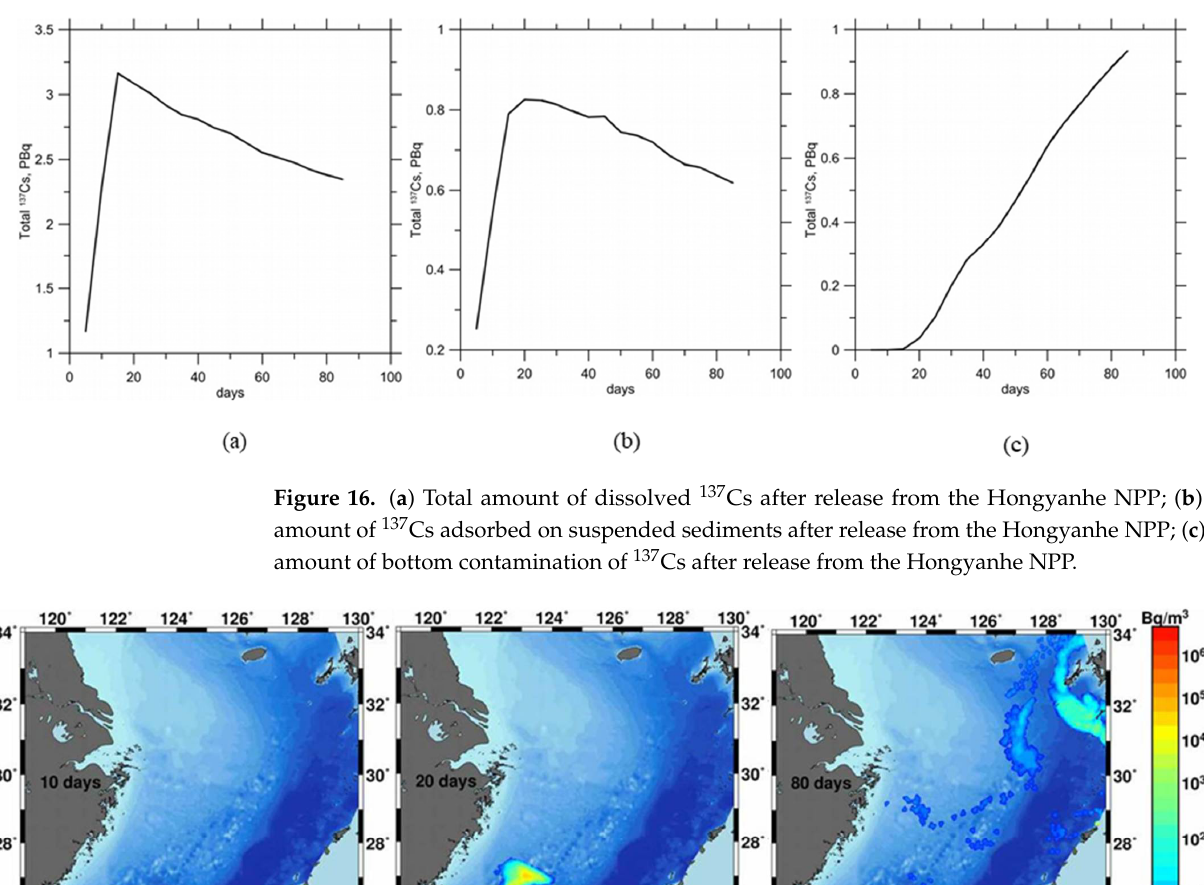
Figure 18. ( a ) Total amount of dissolved 137 Cs after release from the Kuosheng NPP; ( b ) total amount of 137 Cs adsorbed on suspended sediments after release from the Kuosheng NPP; ( c ) total amount of bottom contamination of 137 Cs after release from the Kuosheng NPP. 4. Discussion This paper presents the simulation results of suspended sediment and radioactivity transports in the Bohai, Yellow, and East China seas following the hypothetical release of 137 Cs from the four nuclear power plants located at the surrounding coasts. The shal- lowness and the high concentration of suspended sediments in the Bohai and Yellow seas significantly complicate the modeling of the reactive radionuclides. Therefore, in the study, simulations were carried out using a multi-fraction sediment transport model embedded in the finite-element coupled wave–circulation model SELFE. The sediment model describes erosion and deposition processes for the mixture of cohe- sive/non-cohesive sediments. For the cohesive fraction, settling velocity is corrected for flocculation. This chain of the model is linked with the model of radionuclide transport [13], which describes the key radionuclide transfer processes in the system of water– multi-fraction sediments. In contrast to the Eulerian models used for hydrodynamics and sediment transport processes, we used here the Lagrangian technique to simulate the transport of radionuclides, the adsorption–desorption of particulate radionuclide, decay, deposition, and resuspension from the bottom. The model was chosen for modeling ac-